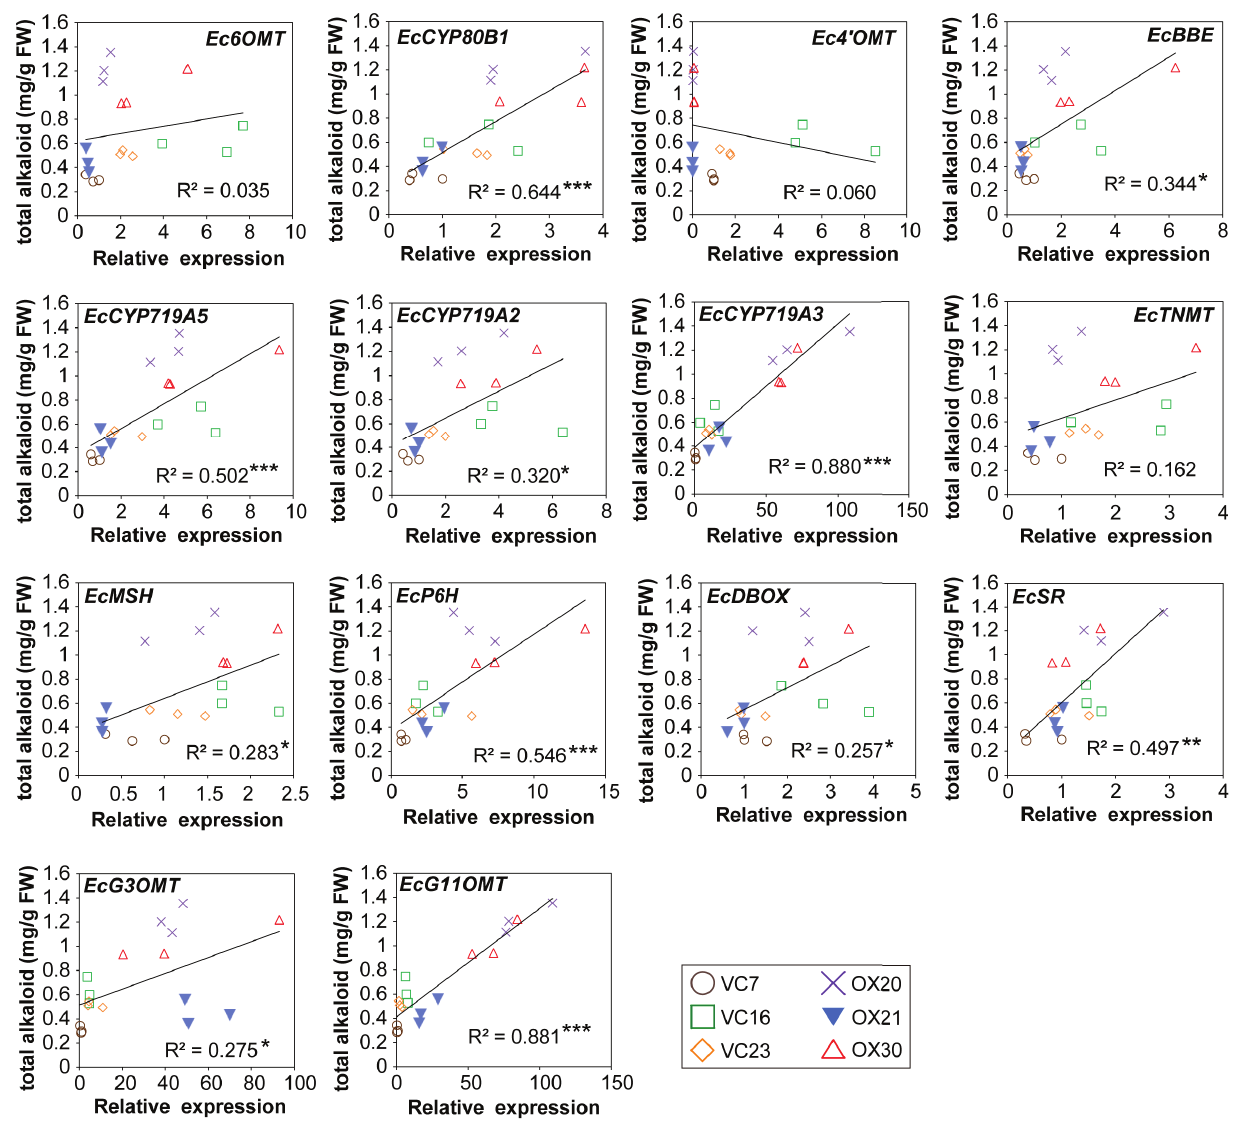
Fig 7. Correlation analysis of the expression of genes encoding biosynthetic enzymesand the accumulation of total alkaloids in flasks growing transgenic California poppy cells. Asterisks indicate significantcorrelations(df = 18; * P < 0.05, ** P < 0.01, *** P < 0.001).